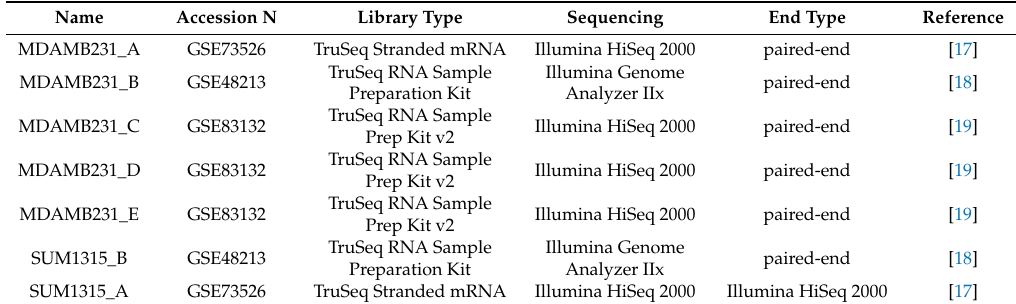
Table 1. Accession number, sample and sequencing information from the NCBI public GEO